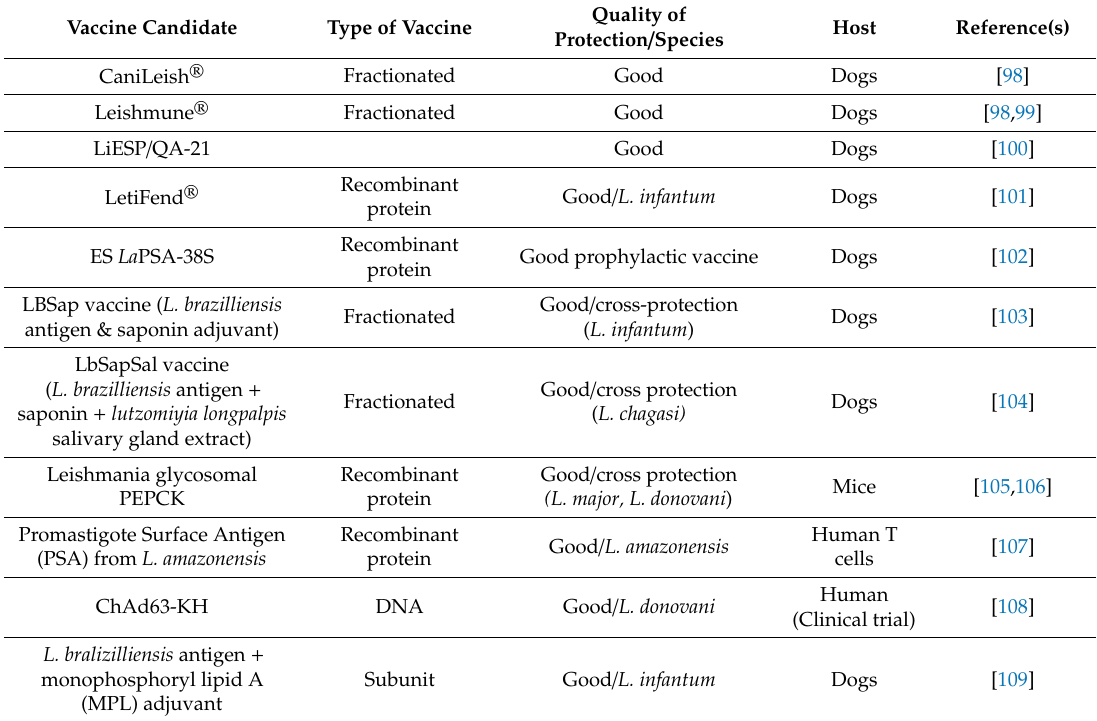
Table 1. Advances in vaccination against